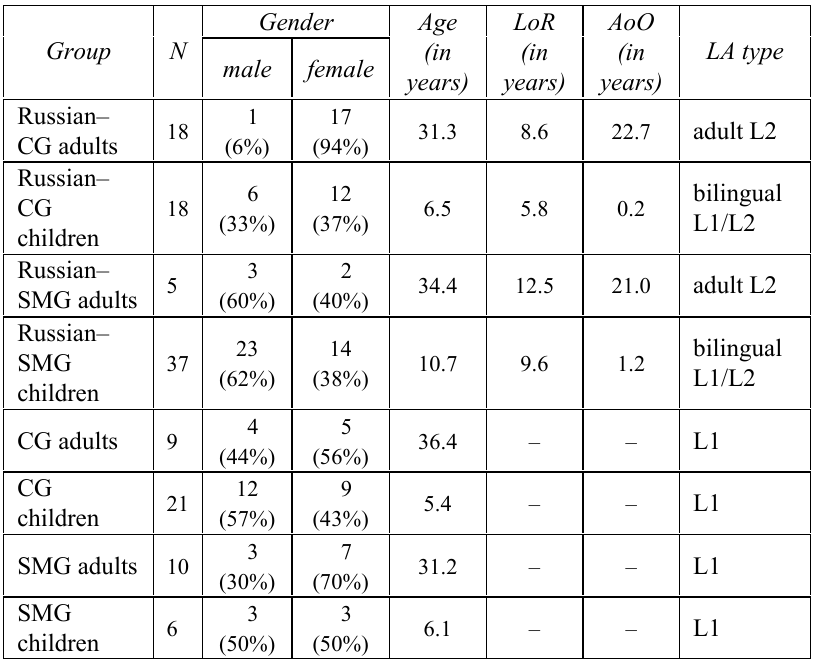
Table 3: Participants in the oral video stimuli